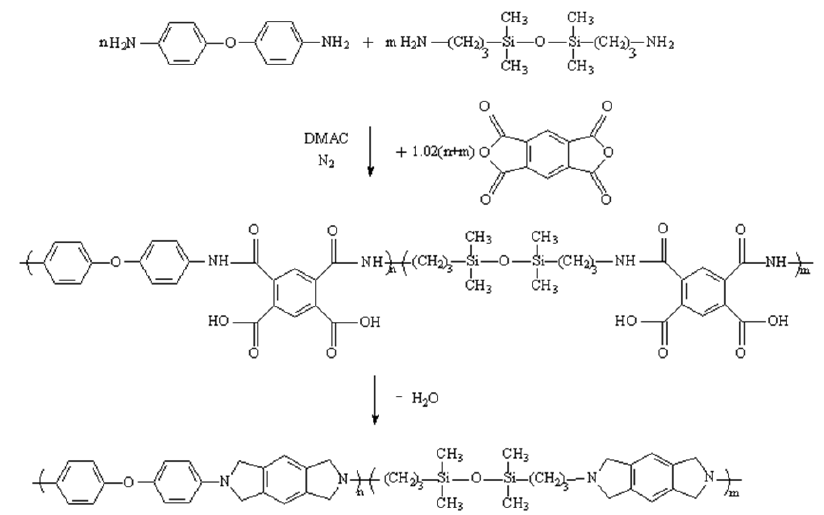
Figure 1. Polyimide reaction equation.